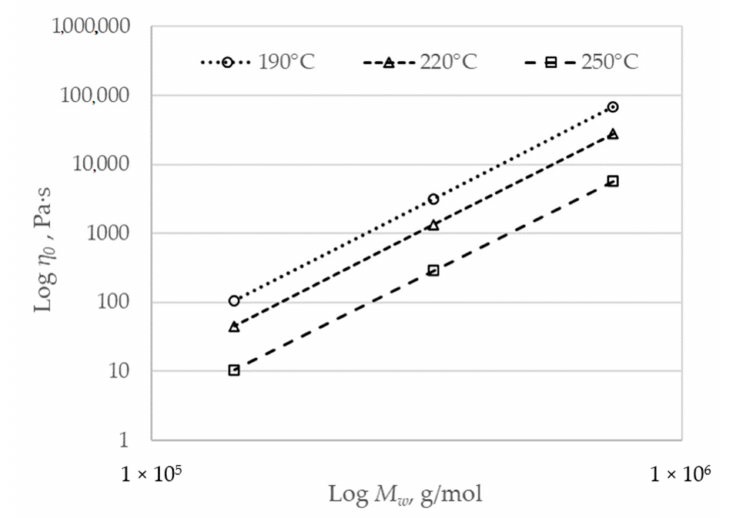
Figure 10. Zero-shear viscosity dependence on molecular weight at di ff erent temperatures.